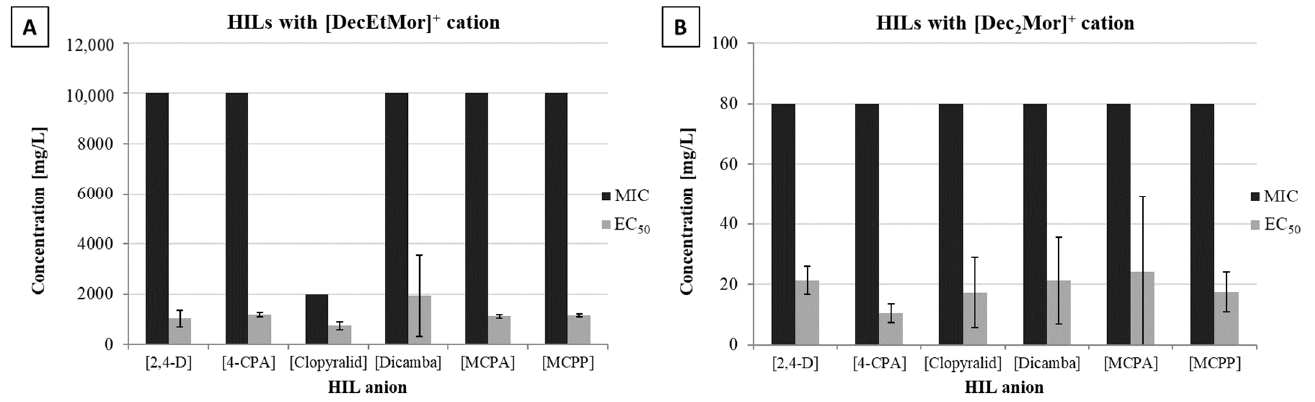
Figure 2. Minimum inhibitory enzyme concentration [mg/L] ± SD (black) and half-maximum effective concentration [mg/L] ± SD (grey) of HILs with either [DecEtMor] + cation ( A ) or [Dec 2 Mor] + cation ( B ). Note the ordinate scale differences between the two panels.